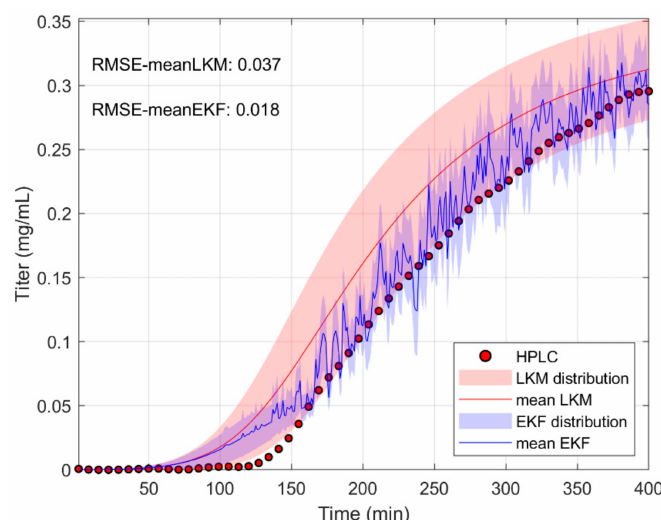
Figure 8. E ff ect of 5% Gaussian distributed perturbations in feed concentration and flow rate, as well as bed porosity on the predictions of the LKM (mean = dark red; standard deviation interval = light red) and the EKF (mean = dark blue; standard deviation interval = light blue) of ROT1 in 200